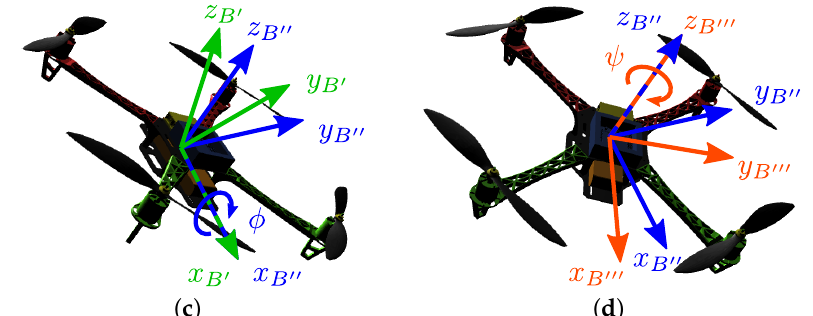
Figure 2. Euler’s angle rotations sequence using the convention ZXY , also called Pitch-Roll-Yaw (PRY). ( a ) Initial quadrotor frame { B } . ( b ) New frame { B (cid:48) } after a pitch rotation of frame { B } with angle θ . ( c ) New frame { B (cid:48)(cid:48) } after a roll rotation of frame { B (cid:48) } with angle φ . ( d ) New frame { B (cid:48)(cid:48)(cid:48) } after a yaw rotation of frame { B (cid:48)(cid:48) } with angle ψ